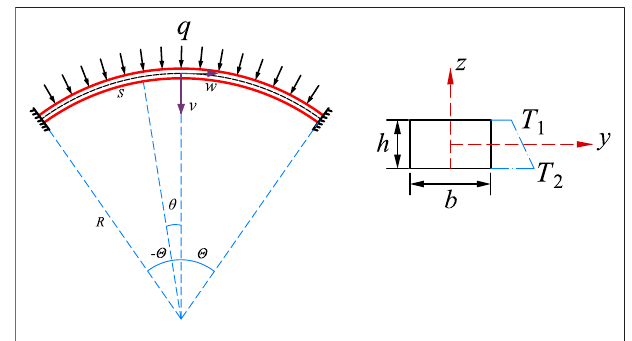
FIGURE1| Anarch under gradient temperature and